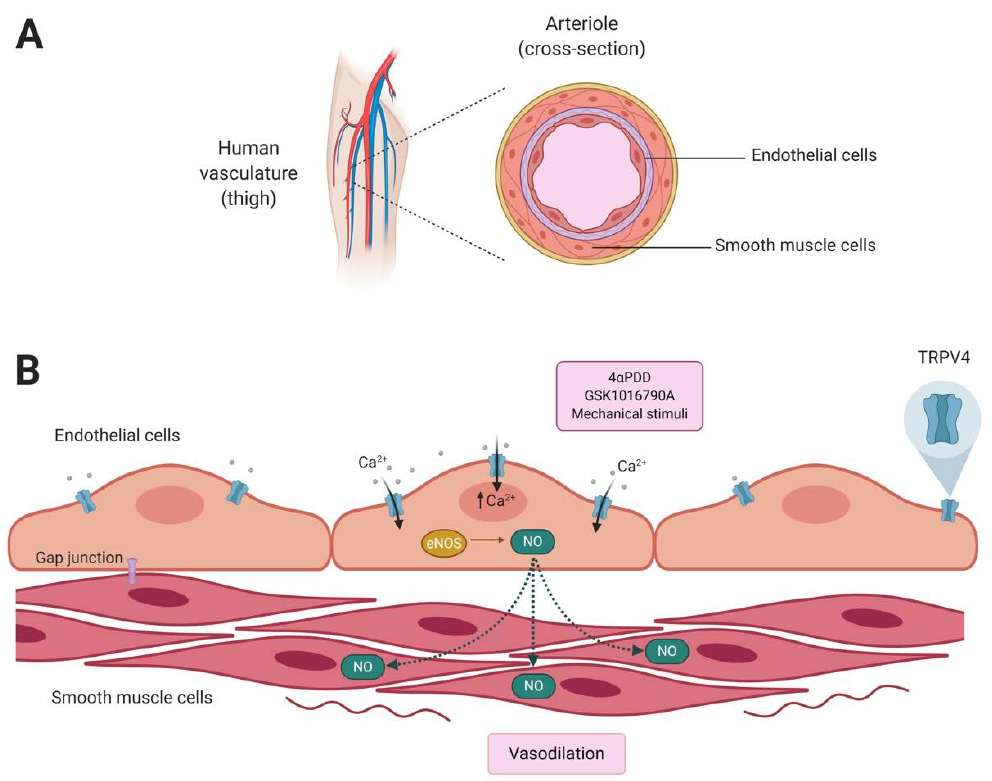
Figure 2. Function of TRPV4 in the vasculature. ( A ) Representation of a region of human vasculature and a cross section of an arteriole. ( B ) Activation of TRPV4 by different stimuli (i.e., 4α -phorbol 12,13-didecanoate or 4αPDD) leads to changes in intracellular Ca 2+ levels, promoting the activity of the enzyme nitric oxide synthase (eNOS) and then increasing the levels of nitric oxide (NO). NO can cross endothelial cell membranes and activate other signaling pathways in smooth muscle cells, inducing vasodilation. Created with Biorender.com.